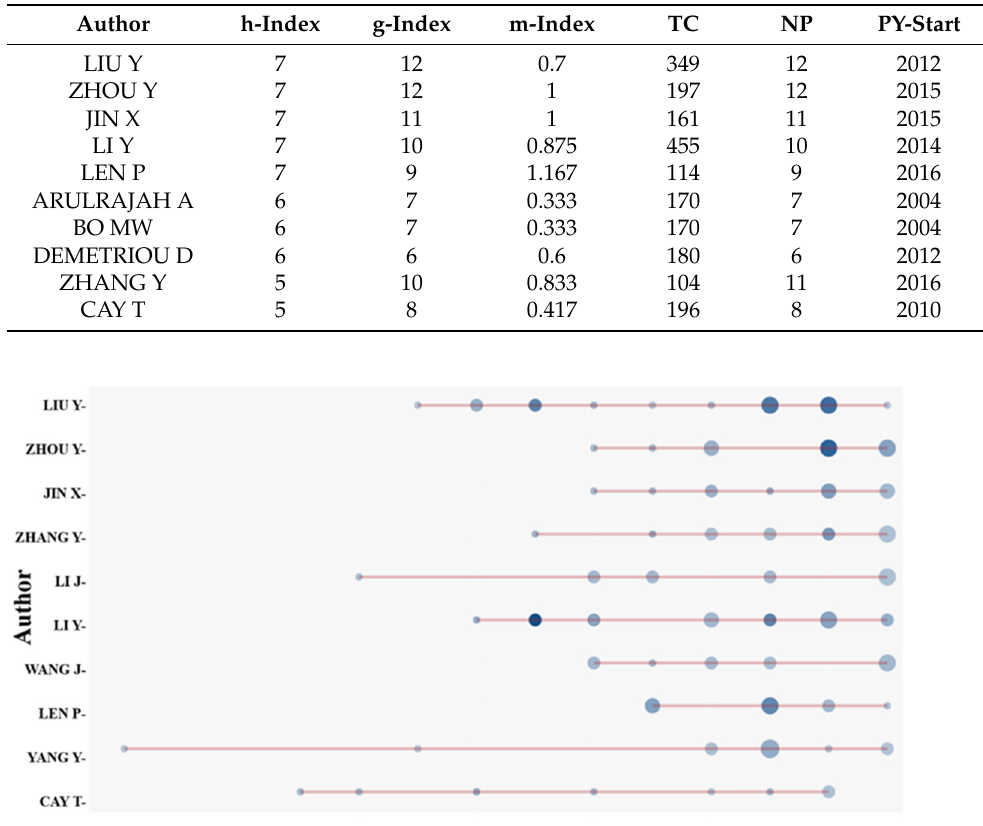
Table 3. Top 10 influential authors in the field of land consolidation.